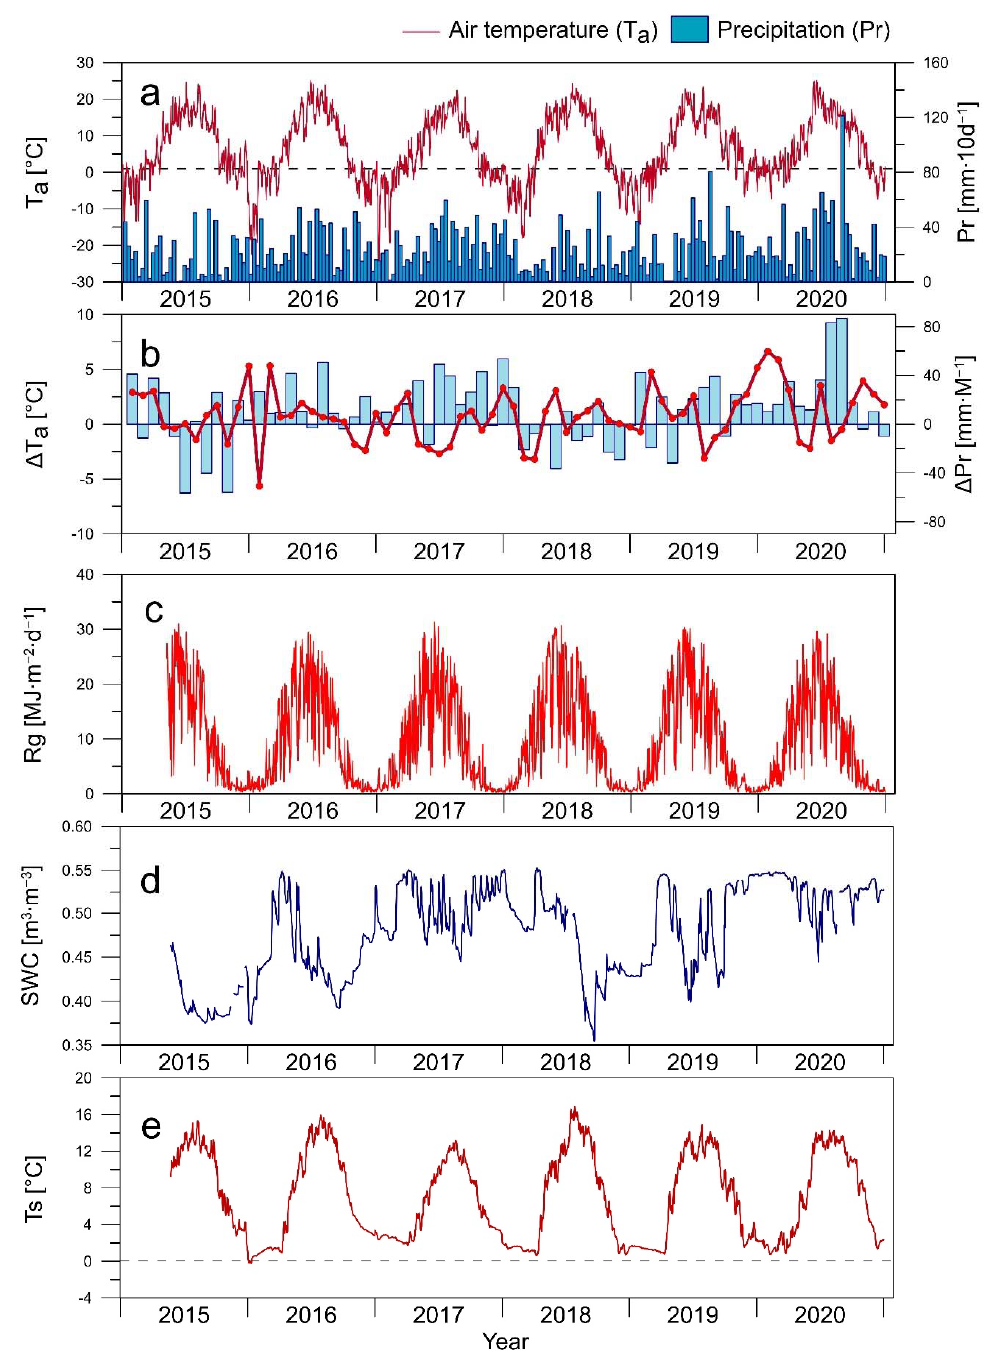
Figure 2. Environmental variables in the 2015–2016 period: ( a ) mean daily air temperature (T a ) at meteorological station “Toropets” and 10-day precipitation sums (Pr) at meteorological station “Lesnoy Zapovednik”; ( b ) anomalies of the monthly mean air temperature ( Δ Ta) at meteorological station “Toropets” and anomalies of the monthly sums of precipitation ( Δ Pr) at meteorological station “Lesnoy Zapovednik” (all anomalies were calculated relative to the monthly means in the 1991–2020 period); and ( c ) global radiation (Rg), ( d ) soil water content (SWC), and ( e ) soil temperature (T s ) obtained at the study site.